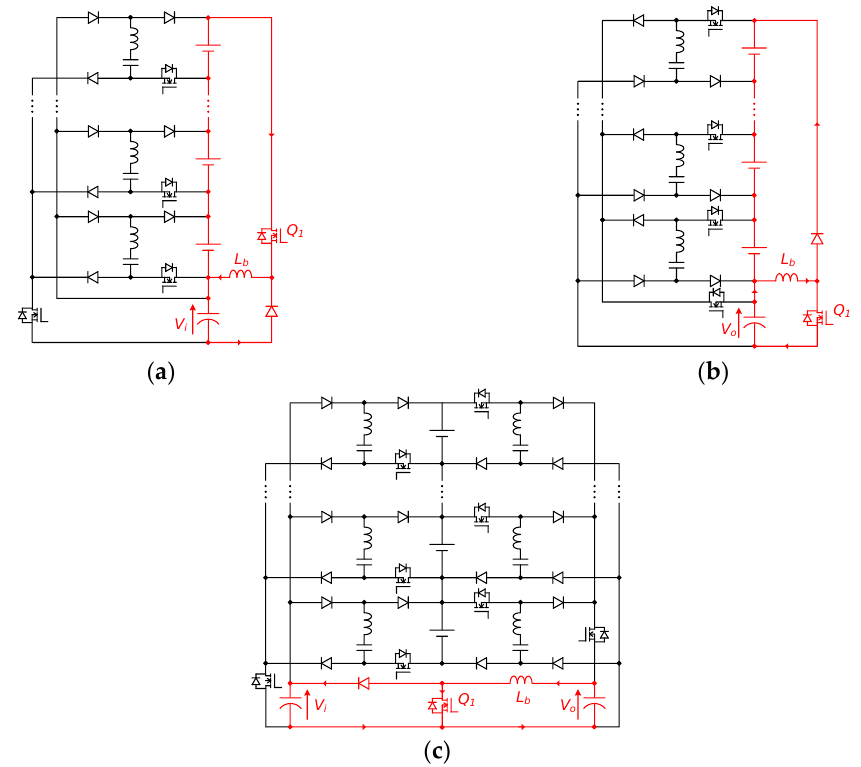
Figure 4. Circuit alteration of the multi-port SC converters; ( a ) string-to-cells implementation with the SIMO configuration and a step-down buck-boost converter; ( b ) cells-to-string implementation with the MISO configuration and a step-up buck-boost converter; and ( c ) cells-to-cells implementation with both the SIMO and MISO SC converters and a step-up boost converter.